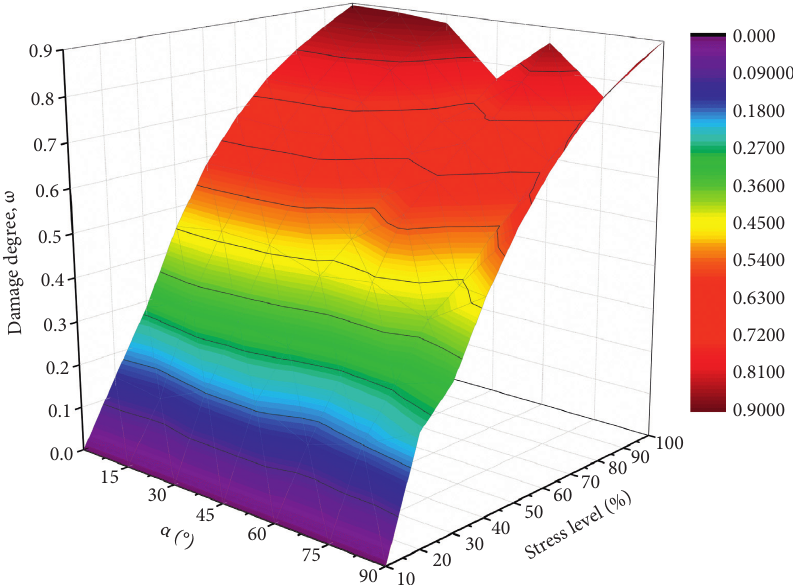
Figure 18: Relationship among damage degree, joint angle, along with stress level.